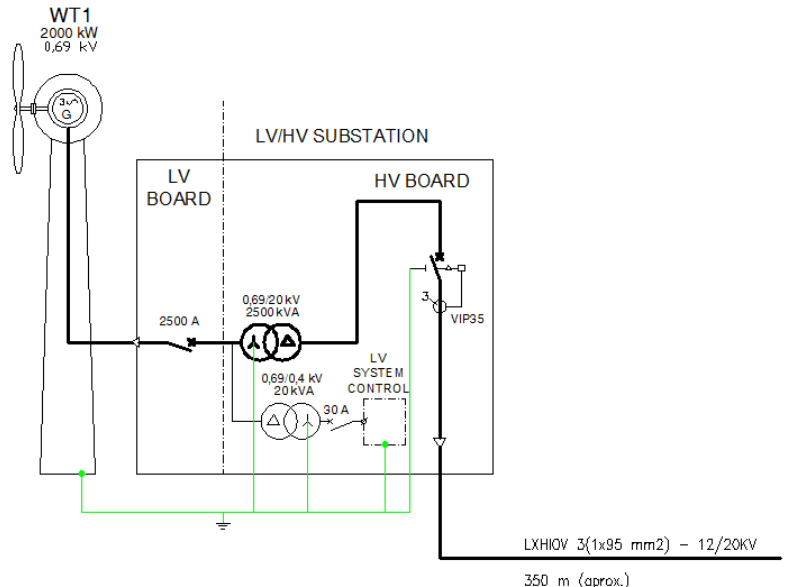
Figure 3. LV/HV substation near the wind turbine